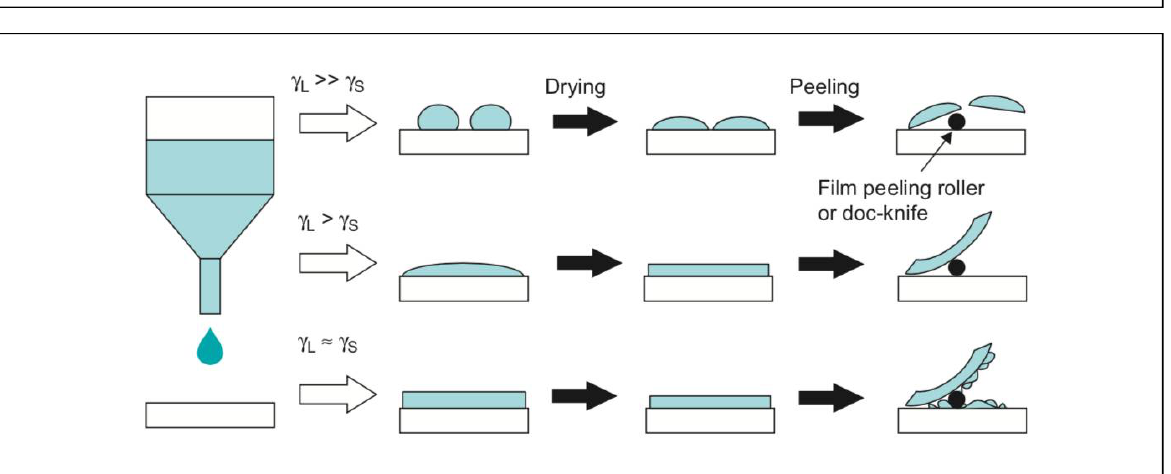
Figure 14: Left: Mould contamination percentage in strawberries coated with modified chitosan containing limonene during storage at 4 °C. Right: Appearance of strawberries coated with modified chitosan-based formulation containing limonene, Adapted from Vu et al ., 2011